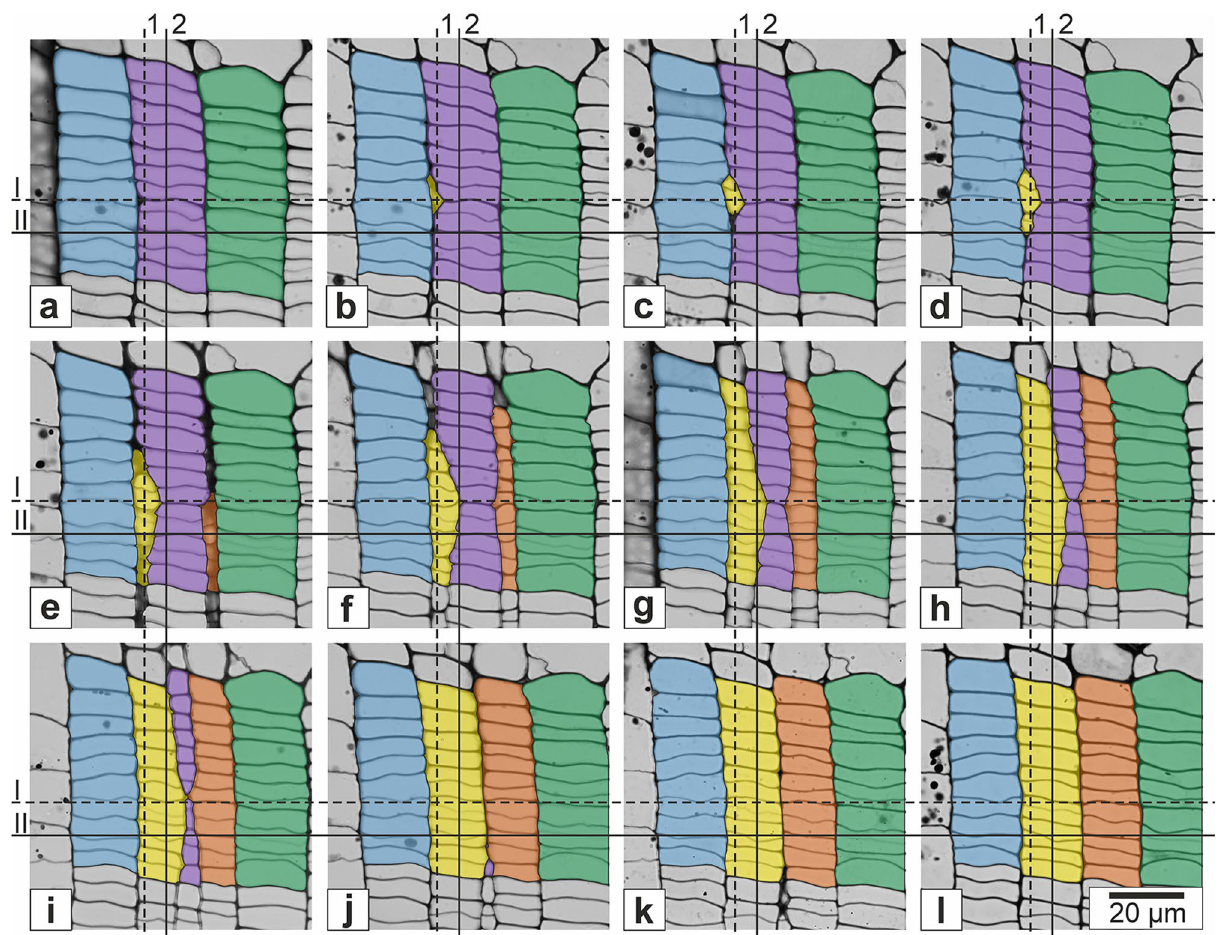
Figure 6. Long series of semi-thin transverse sections of the vascular cambium of Robinia pseudoacacia L. ( a - l ). Five radial files of cambial cells were distinguished. Three files in a are coloured as: blue, violet, and green. Files derived from intrusively growing initials are coloured in yellow and orange. Roman and Arabic numerals describe lines showing location of reconstructed tangential and radial planes respectively (see Figs. 7 and 8). Line I corresponds to approximate location of cambial initial layer. Adobe Photoshop CS6 Extended ver.13.0 × 64 (https:// www. adobe. com), and CorelDRAW Graphics Suite SE ver. 18.2.0.840 (https:// www. corel draw. com) were used.